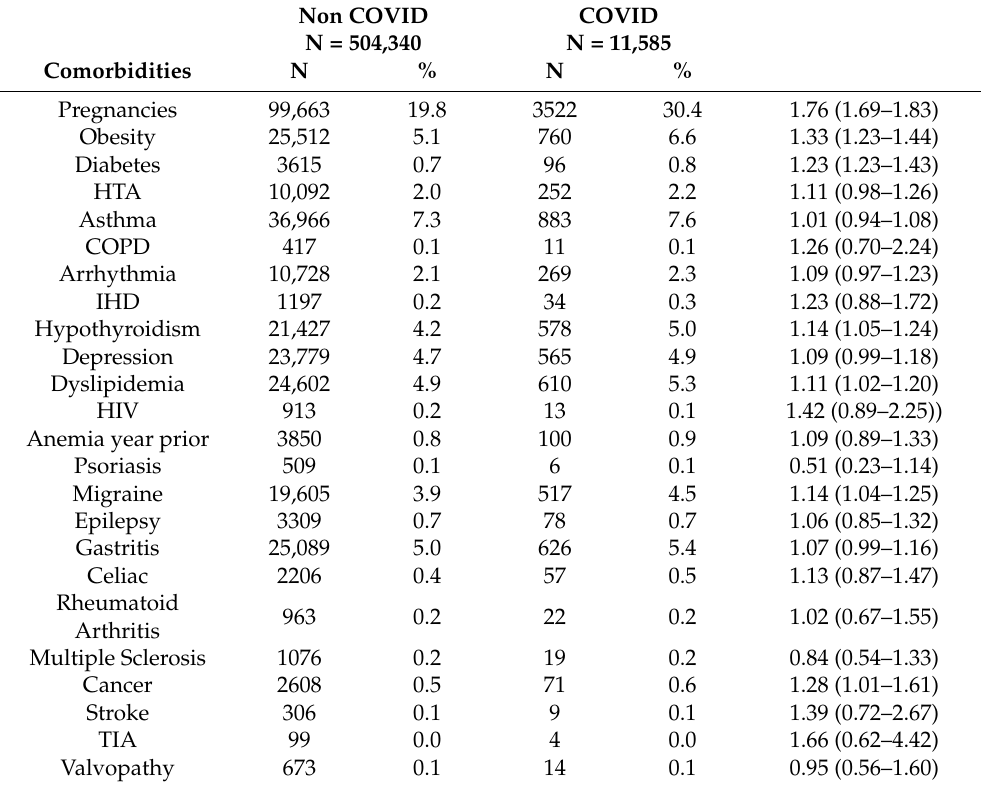
Table 2. Baseline characteristics and its association with COVID